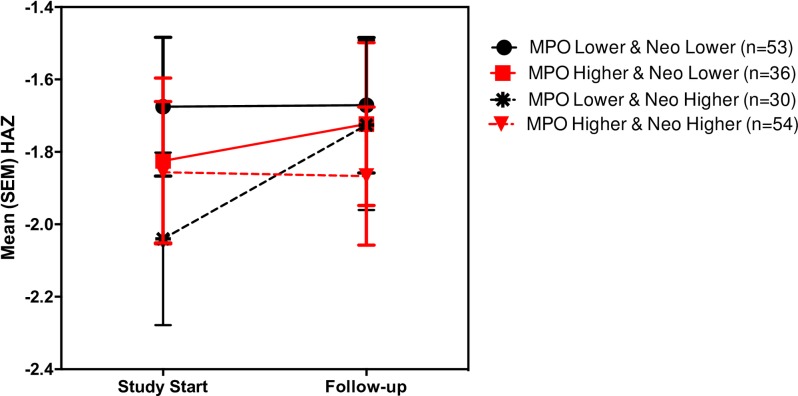
Repeated measures MANOVAs show interactions in predicting growth between MPO and Neo: high MPO when combined with high neopterin associate with poorest growth.